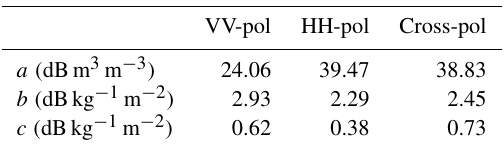
Table 2. Estimated regression coefficients per polarization for the period 7–13 June 2018 (Eq.